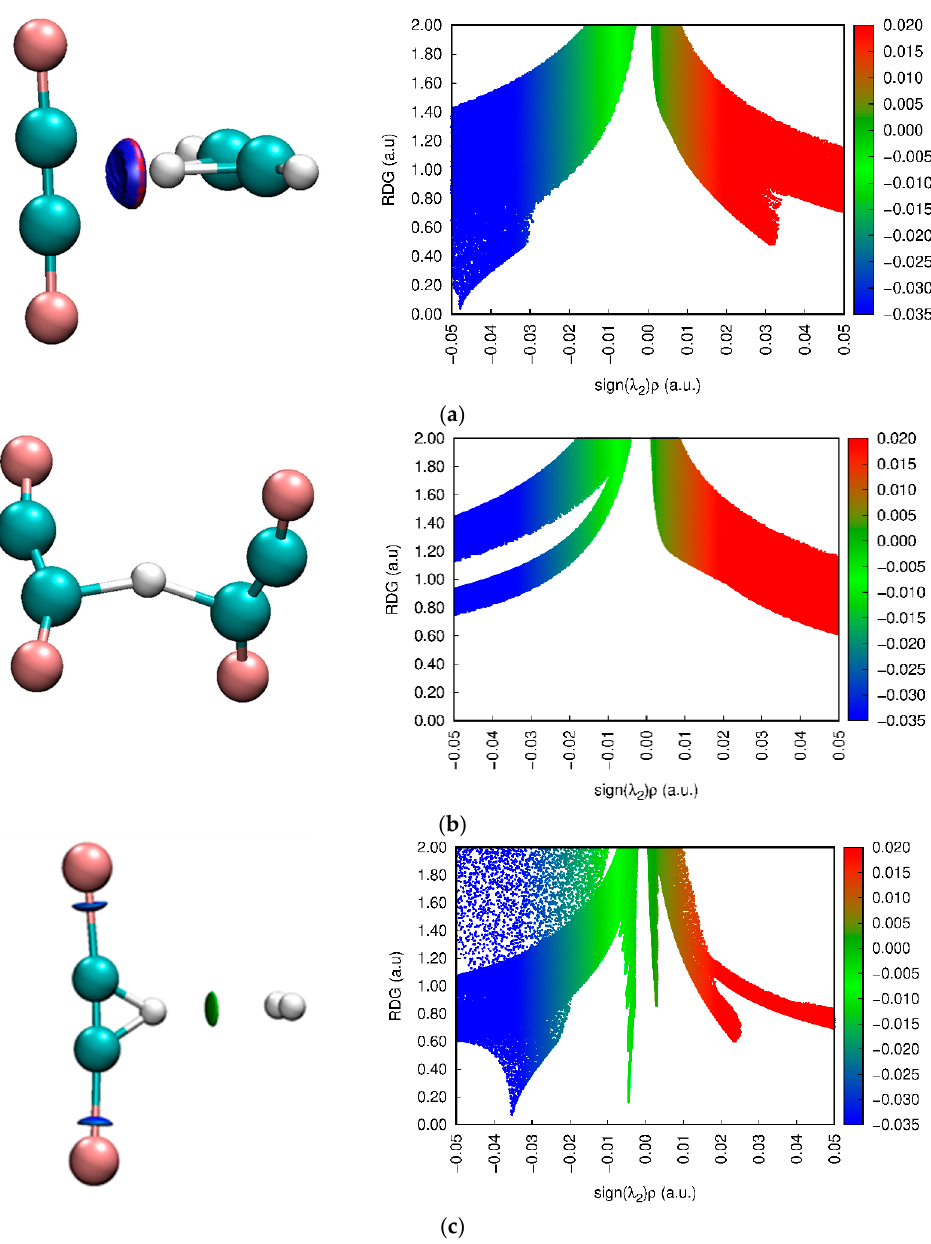
Figure 4. The RDG plots ( right ) and the corresponding molecular systems ( left ) of selected proton ‐ bound complexes. The following complexes are presented: ( a ) C 2 H 3+ ‐ C 2 F 2 , ( b ) C 2 F 2 H + ‐ C 2 F 2 , ( c ) C 2 Li 2 H + ‐ H 2 .